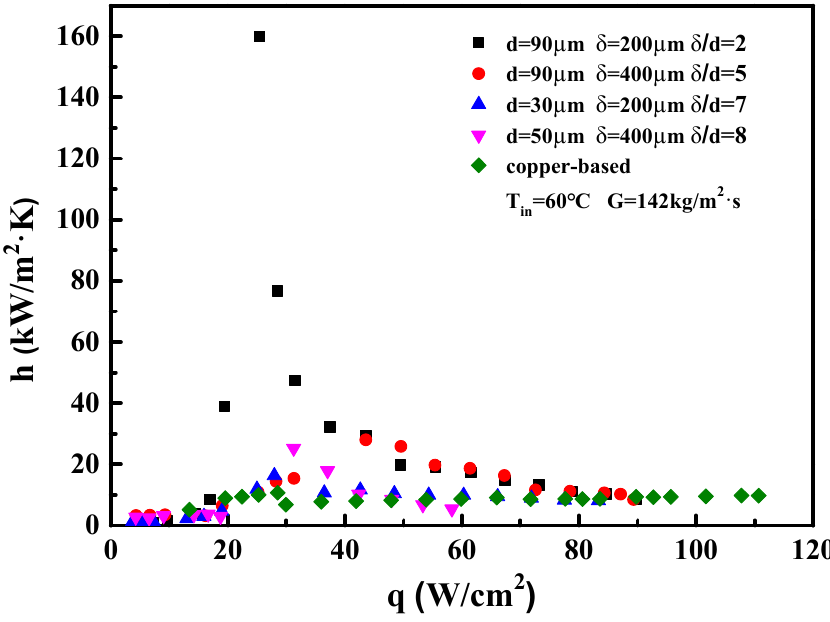
Figure 9. Heat transfer coe ffi cient versus heat flux for porous and copper-based microchannels.